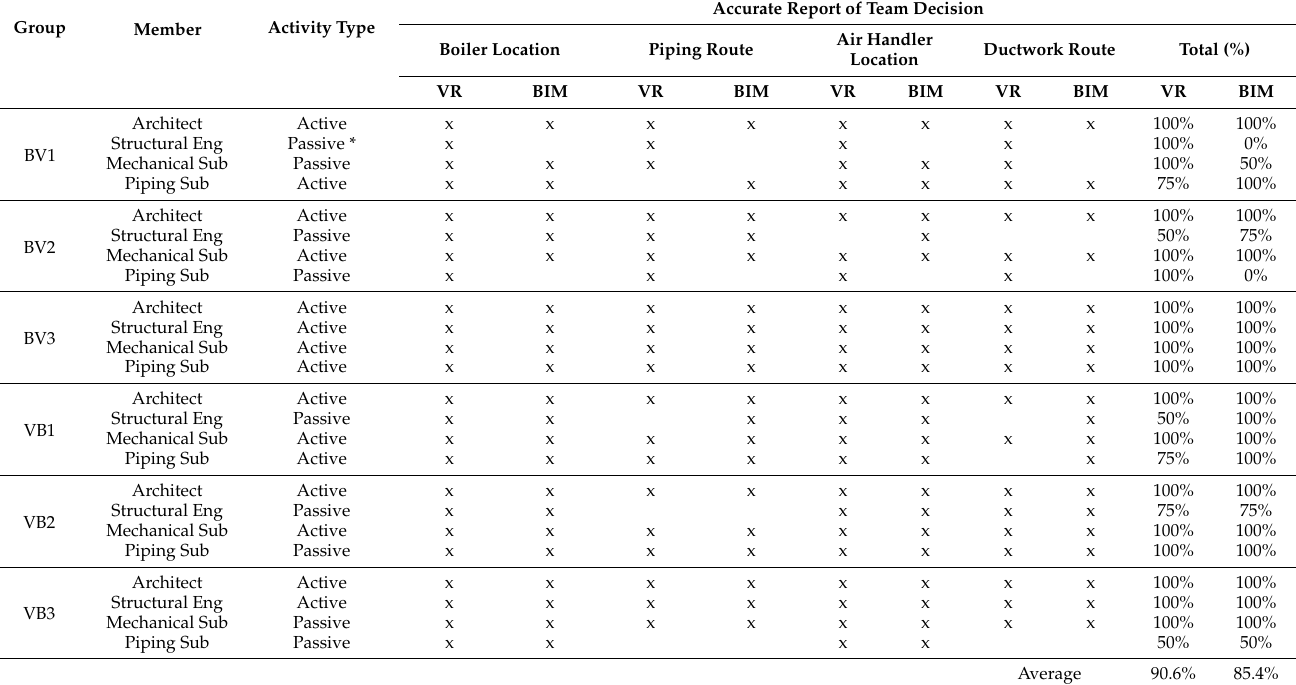
Table 3. Team member